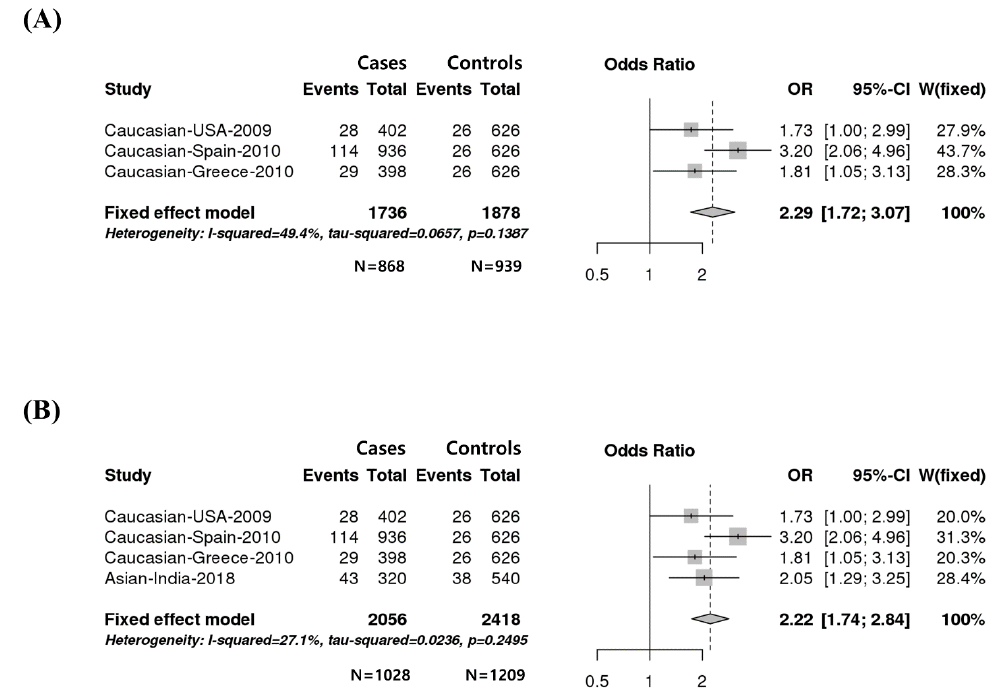
Figure 1. ( A ) Forest plot of the association between the rs4986790 single nucleotide polymorphism (SNP) of the TLR4 gene and susceptibility to human immunodeficiency virus (HIV) infection in a Caucasian population. ( B ) Forest plot of the association between the rs4986790 SNP and susceptibility to HIV infection in four populations. Forest plots of odd ratios (ORs) were calculated using an additive model (A allele vs. G allele). The number of each column of “Cases” and “Controls” indicates number of alleles. “N” indicates the number of people.